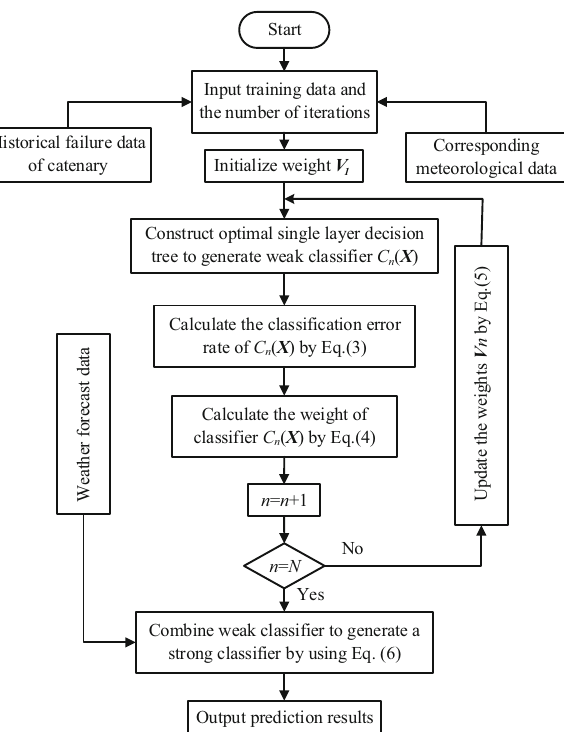
Fig. 5 Flow chart of the catenary fault